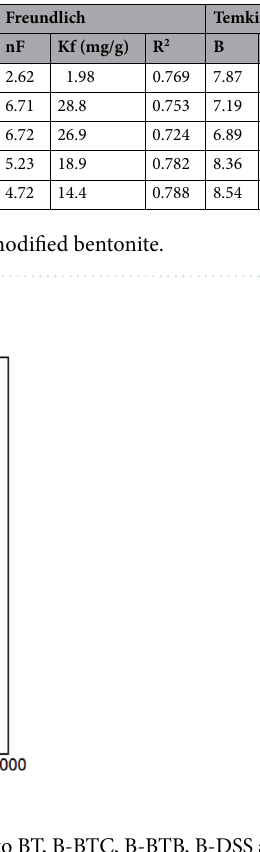
Figure 7. Langmuir Isotherm for the adsorption of DBT onto BT, B-BTC, B-BTB, B-DSS and